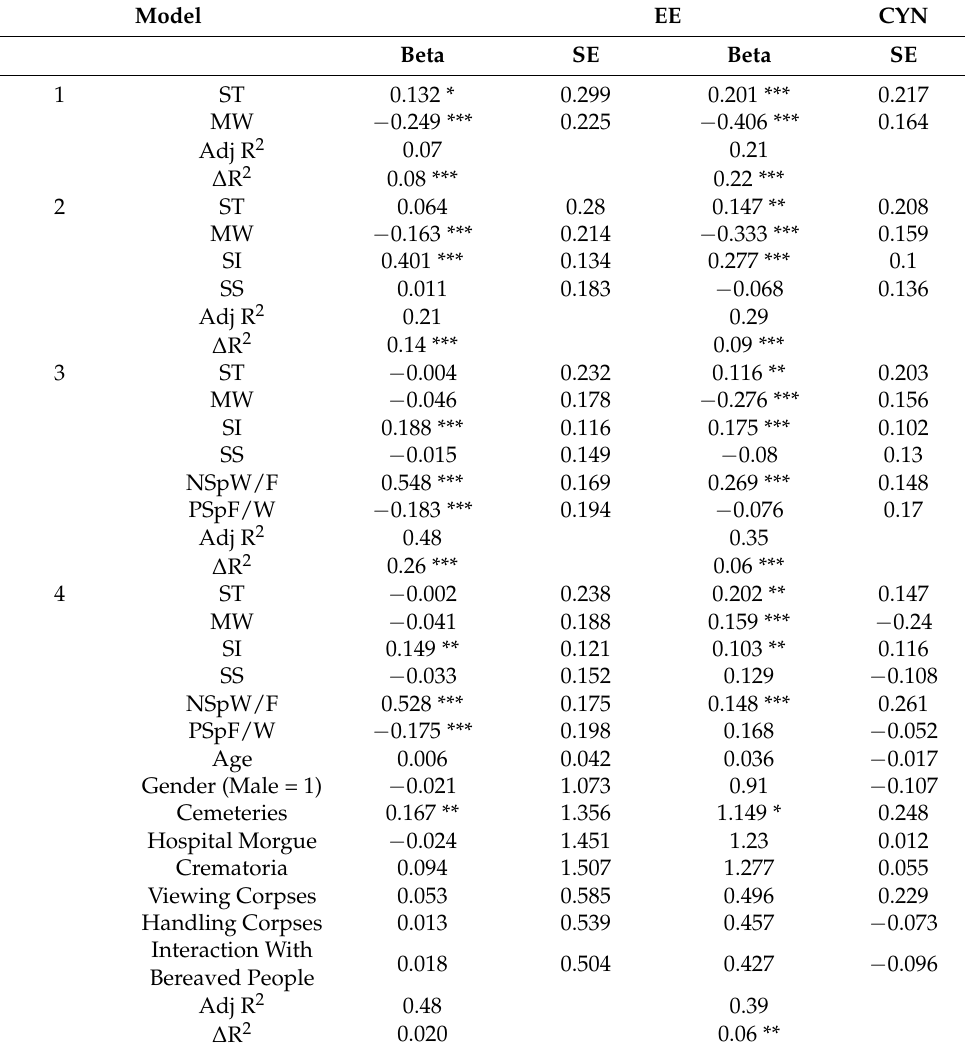
Table 2. Regression parameters: standardized coefficients and overall changes in R 2 for emotional exhaustion and